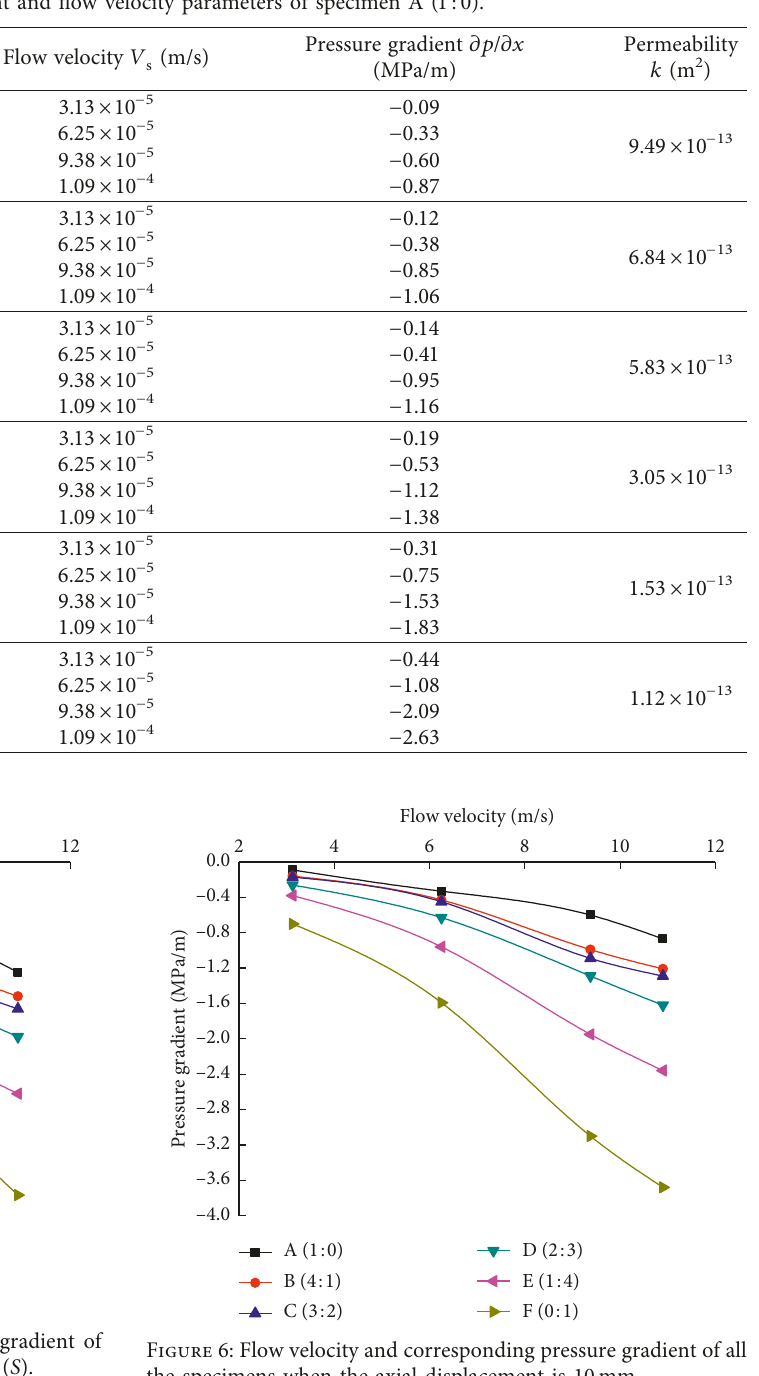
Table 1: Pressure gradient and flow velocity parameters of specimen A (1: 0).